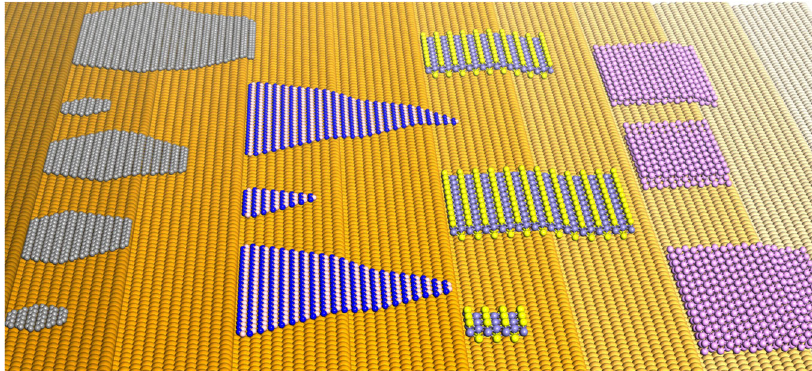
Fig. 5 Schematics showing well-aligned 2D materials (from left to right are graphene, hBN, FeSe and black phosphorene, respectively.) on a vicinal fcc (111) surface. One edge of each island is passivated by a high-symmetric step edge of the